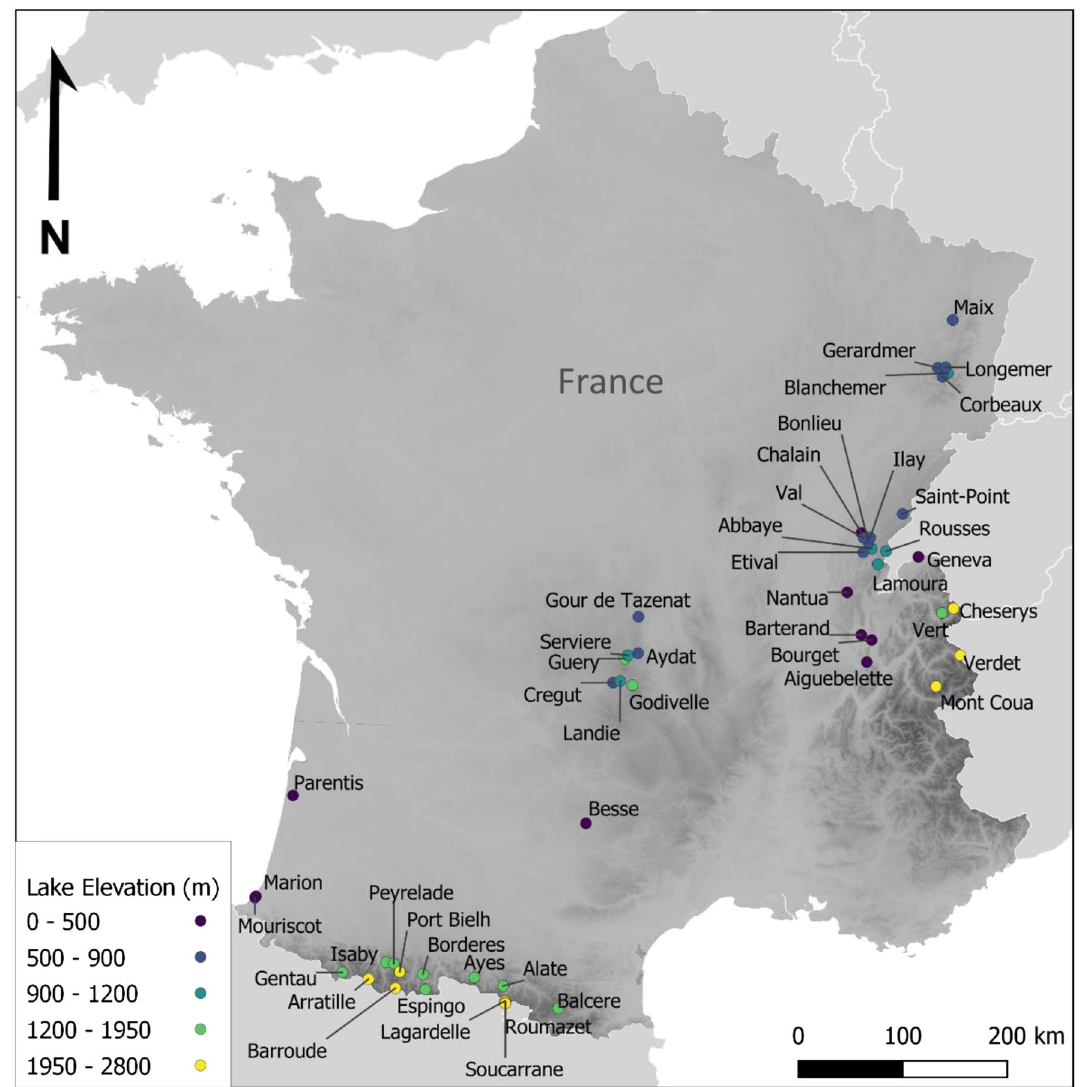
Figure 1. Location of the 48 studied lakes. The colours correspond to associated elevation range (cf. legend), the grey gradient illustrates the elevation terrain (DEM; source: https:// srtm. csi. cgiar. org/) within the geopolitical boarders of